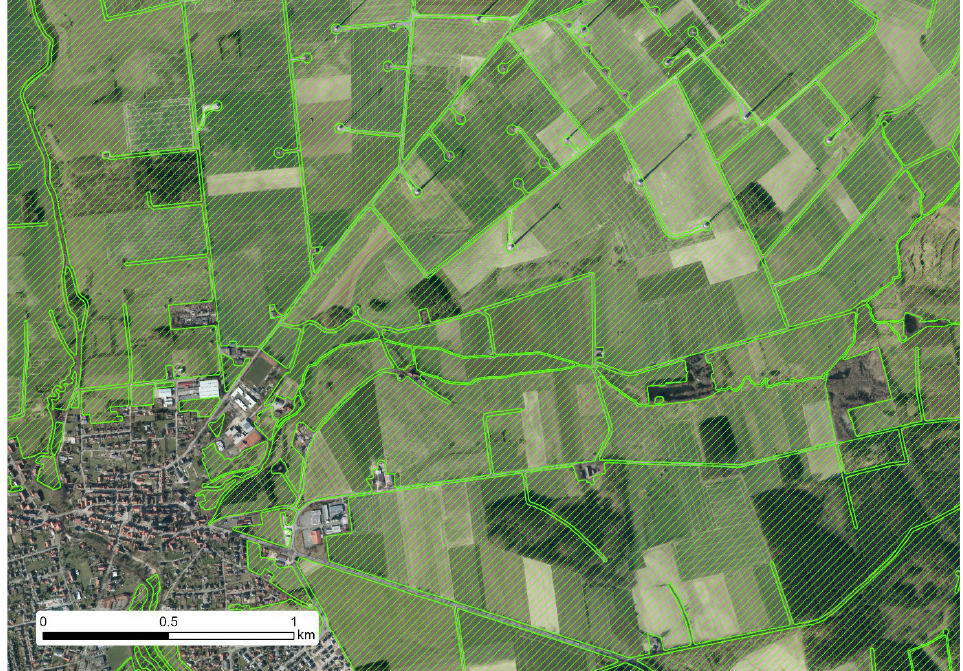
Figure 3. A typical landscape overlaid by the Positive Layer. Only archaeologically relevant areas such as fields and forests are included, while modern infrastructure, e.g., settlements, streets, and windmills, were removed. Data source: [25].